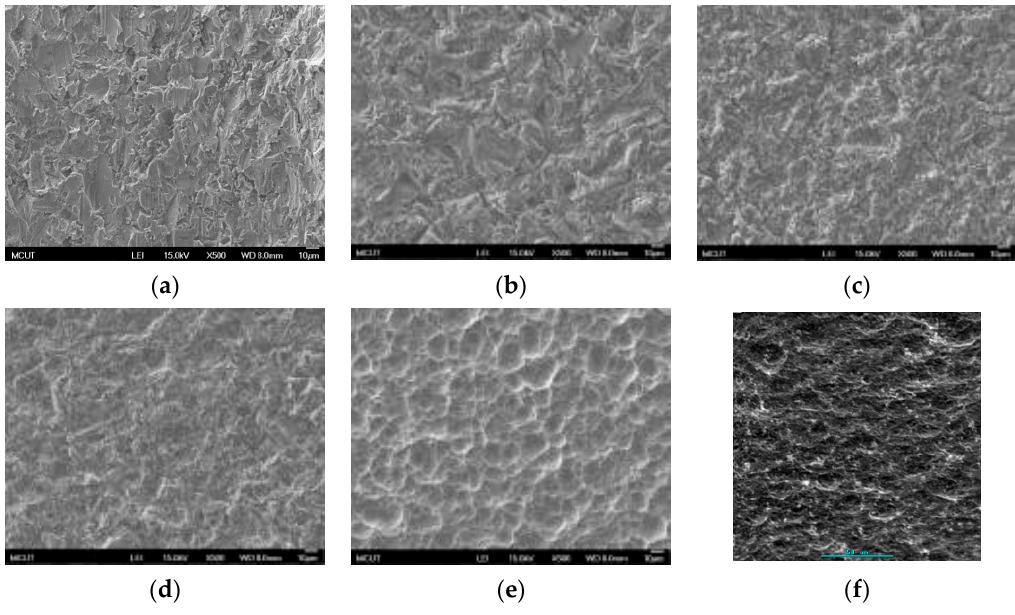
Figure 6. SEM images of Ti-6Al-4V surface after a single acid etching at RT and at BT (500× magnification): ( a ) sandblasting; ( b ) H 2 SO 4 for 10 min; ( c ) HCl for 10 min; ( d ) H 2 SO 4 (120 °C) for 10 min; ( e ) HCl (80 °C) for 10 min; and ( f ) HF for 10 min.